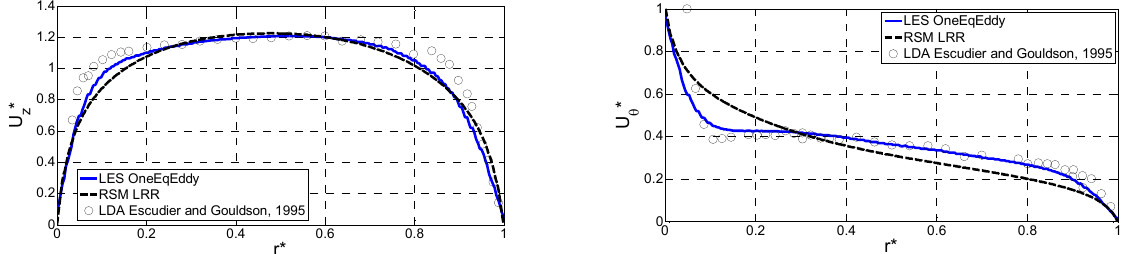
Figure 3. Steamwise and spanwise velocity profiles. Comparison between numerical models (RSM and LES) and the experimental measurements of Escudier and Gouldson (1995) [20].